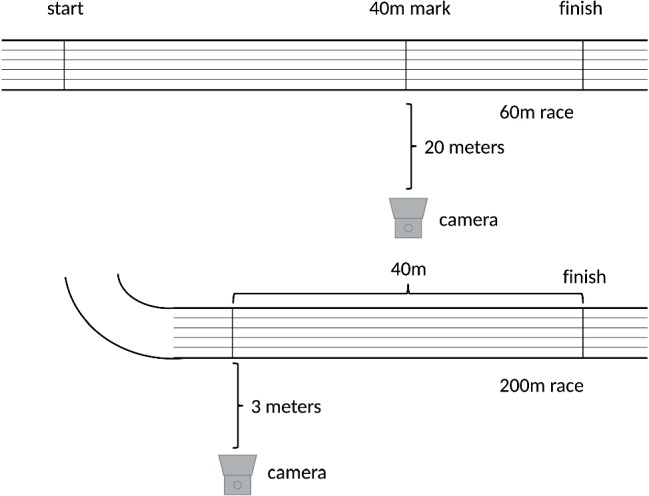
Camera locations.